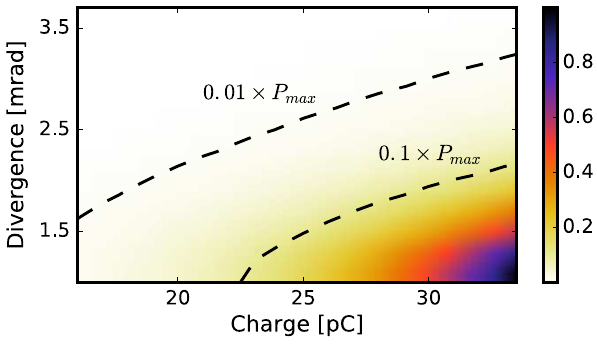
FIG. 8. Normalized FEL peak power at 200 nm versus electron beam charge and divergence. Beam transport simulation with OCELOTwithout collective effects using the S2I-CM optics with r 11 ¼ r 33 ¼ 10 and r 56 ¼ 0 . 4 mm. Normalized emittance pre- served at 1 mm mrad. FEL simulation with CHIMERA.